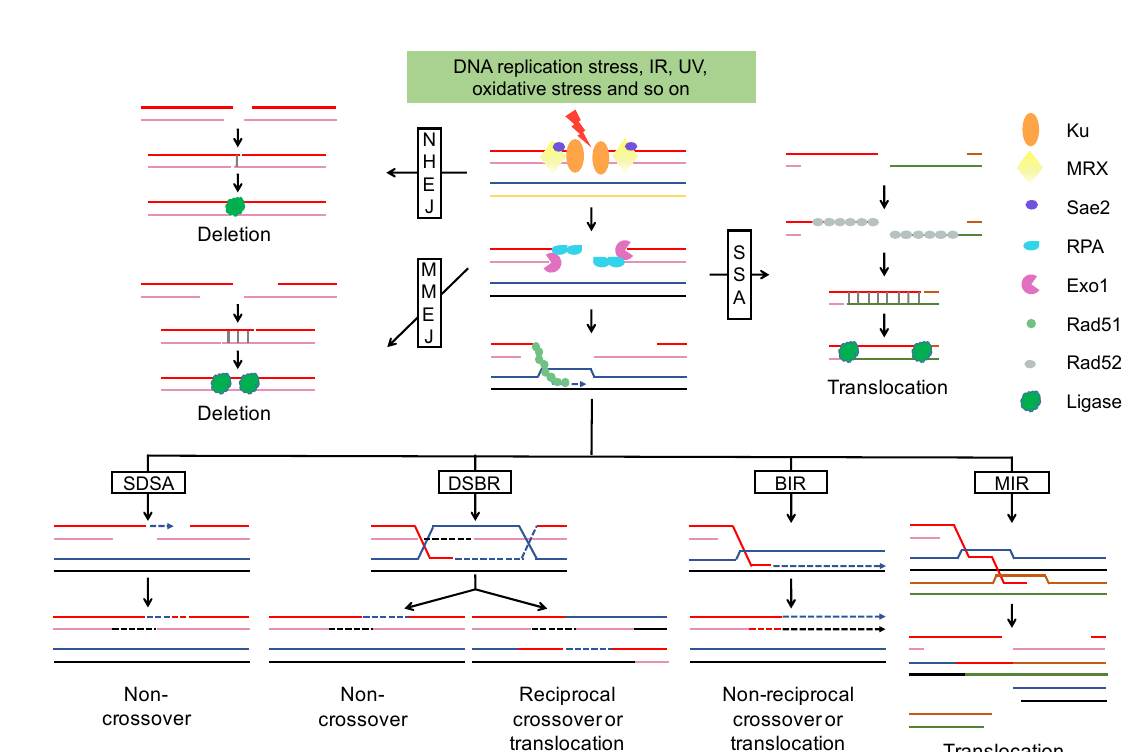
Figure 1. DSB end resection and repair pathway. After DSB formation, Ku binds to the DSBs and promotes the classic NHEJ pathway. NHEJ generally cause small deletions. The MRX-Sae2 complex initiates the resection and Exo1 extends the resection to expose longer 3 ′ ssDNA that is bound by RPA to prevent degradation. MMEJ and SSA are two alternative end-joining pathways, both of them can result in deletion or translocation. In the homologous recombination pathway, the 3 ′ ssDNA is coated with Rad51 and invades the homologous template to form a D-Loop. DNA synthesis is represented by an arrow and newly synthesized DNA by a broken line. Homologous recombination leads to multiple outcomes (non-crossover, crossover, gene conversion, and translocation) depending on what templates were used and in which way the D-Loop was processed. Abbreviations: NHEJ, Nonhomologous end joining; MRX, Mre11-Rad50-Xrs2 complex; RPA, replication protein A; MMEJ, microhomology-mediated end joining; SSA, single strand annealing; SDSA, synthesis-dependent strand annealing; DSBR, double-strand break repair; BIR, break-induced replication; MIR, multi-invasion-induced rearrangement.